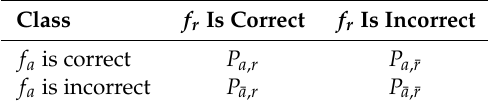
Table 1. Cases of classification results, two